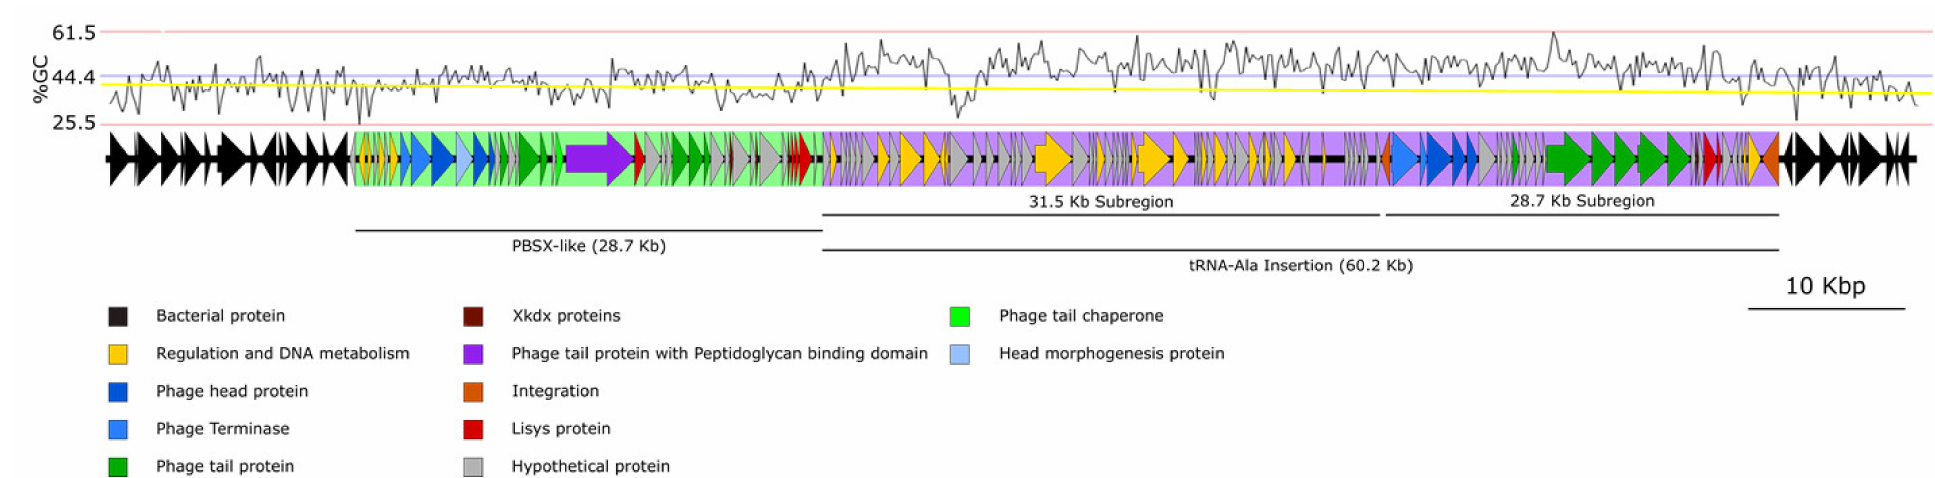
Figure 1. Schematic representation of the genomic area detected by PHASTER (coloured) and flanking regions (black). The PBSX-like particle is highlighted in green, while the tRNA-Ala is marked in purple. The subregions found in the tRNA-Ala insertion are also indicated. The GC content is showed at the top of the figure. The blue line indicates the mean GC content of the 98 Kb fragment, and the yellow line shows the average GC content for B. pumilus . The potential function of each ORF was inferred by